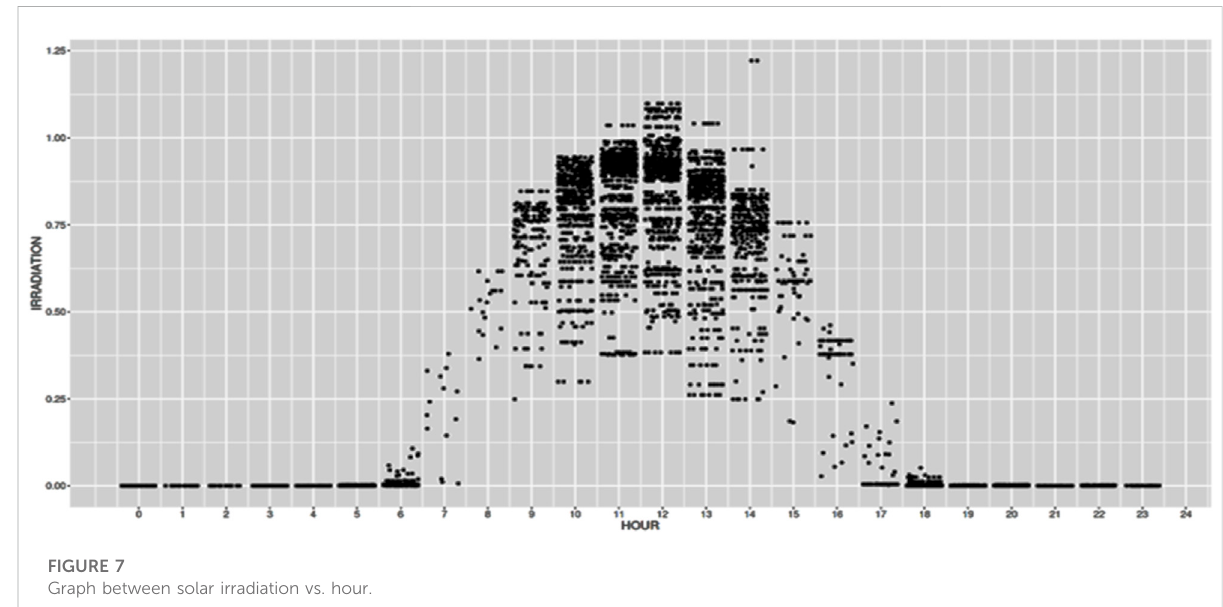
FIGURE 7 Graph between solar irradiation vs. hour.